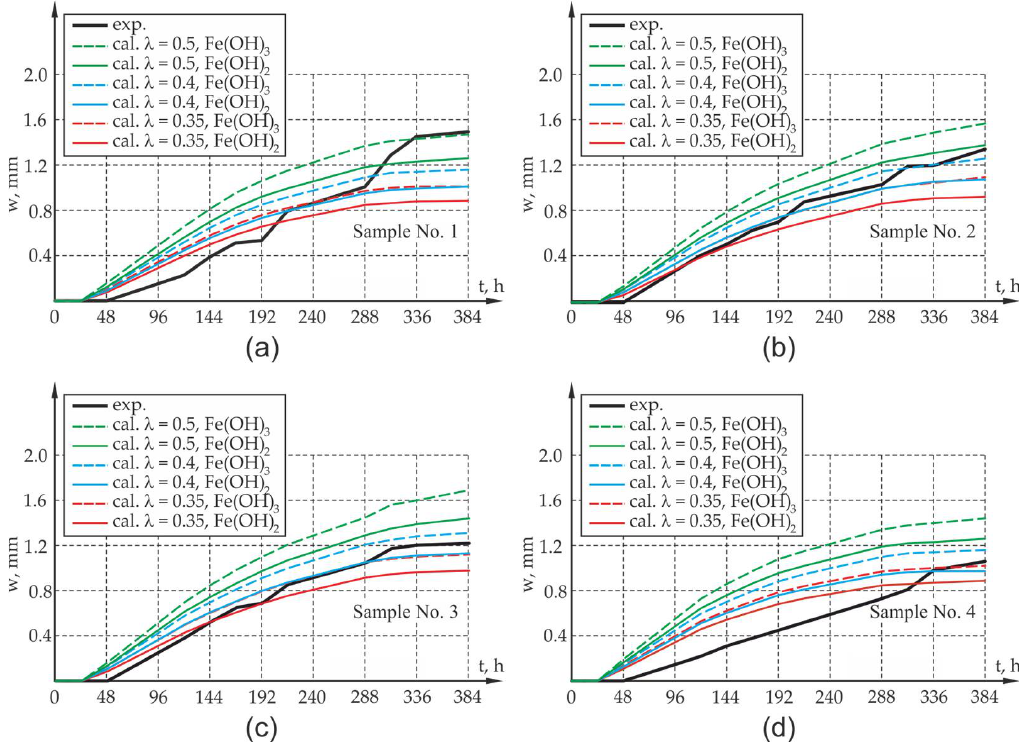
Figure 11. Average values of crack width at points of the elements’ edges on the sections A1A2 and B1B2 of the reinforced concrete sample at points R1 and R2 together with the calculation results for the 50%, 60% and 65% reductions of the impact intensity of corrosion products ( λ = 0.5, λ = 0.4, λ = 0.35): ( a ) sample P1, ( b ) sample P2, ( c ) sample P3, ( d ) sample P4.